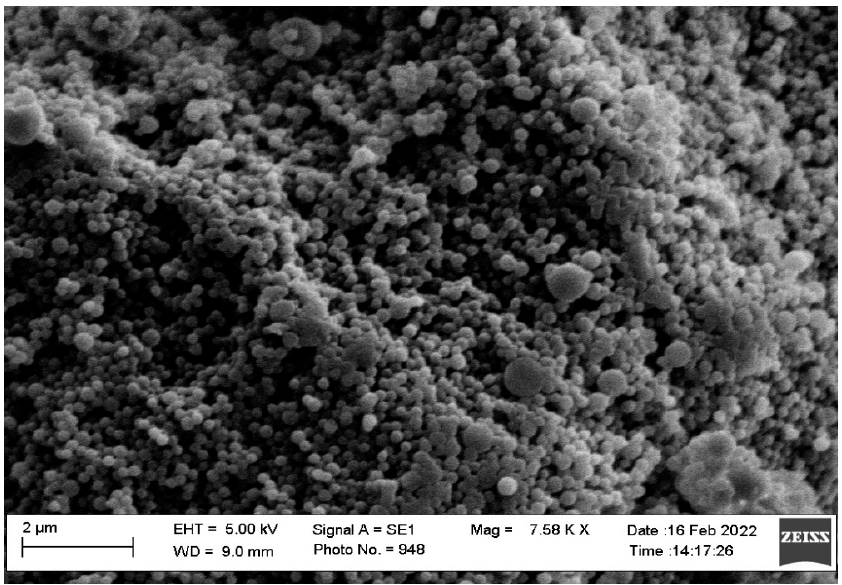
Figure 7. SEM images of optimized LPHNPs (SLPN4). Table 2. Percent cell viability against concentration.